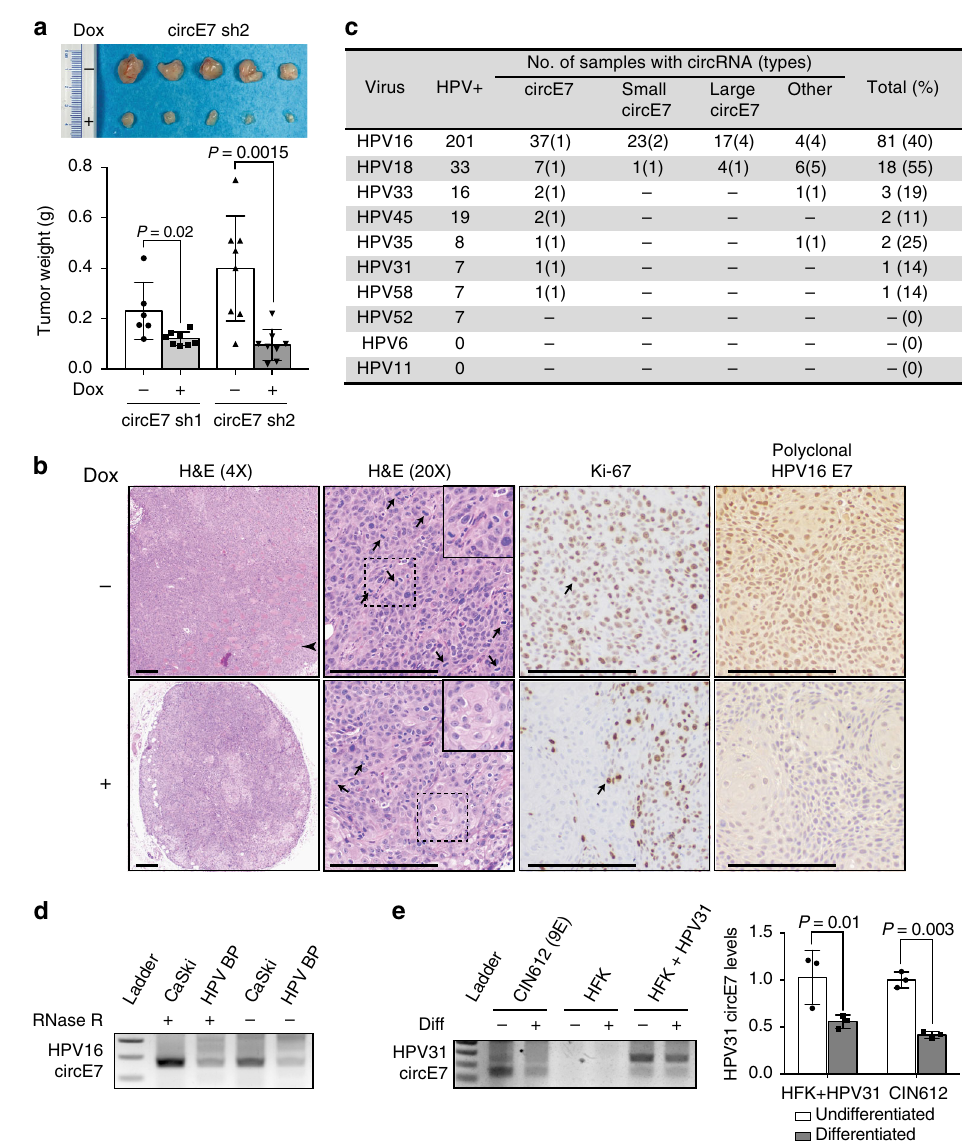
Fig. 5 Biological functions of circE7 in tumors and episomal HPV. CaSki cells (4×10 6 ), which had been stably transduced with the indicated construct, were xenografted onto the fl anks of NSG mice ( n = 8 per construct). Mice were given water with or without doxycycline (1 mg/mL) as indicated. a Image of representative CaSki tumor xenografts dissected from the indicated mice after 21 days (top). Weights of CaSki tumors with or without dox-induced circE7 sh1/2 expression (bottom). b Representative images of tumors formed by CaSki xenografts without (top) or with (bottom) doxycycline. Arrowhead indicates an area of invasive tumor. Arrows indicate mitotic fi gures and Ki-67-positive cells. Dashed box indicates area of detail. Scale bars, 200 μ m. c TCGA RNA-Seq data (CESC, HNSC) was analyzed with vircircRNA and backsplices with ≥ 2 reads were tabulated. d RT-PCR from CaSki or HPV BP cells that possess integrated or episomal HPV16 genomes with or without RNase R reveals the presence of circE7 in both samples. e Human foreskin keratinocyte (HFK), keratinocytes infected with religated HPV31 (HFK + HPV31), or a HPV31 infected cell line derived from a grade II cervical biopsy (CIN612) were induced to differentiate with high calcium. Levels of HPV31 circE7 were assessed by RT-PCR (left) or RT-qPCR (right). Calcium-induced differentiation signi fi cantly decreased levels of HPV31 circE7. RT-PCR is representative of 4 independent experiments. Data are shown as mean ± s.d. P values (indicated above relevant comparisons) were calculated with two-tailed t test ( a , e